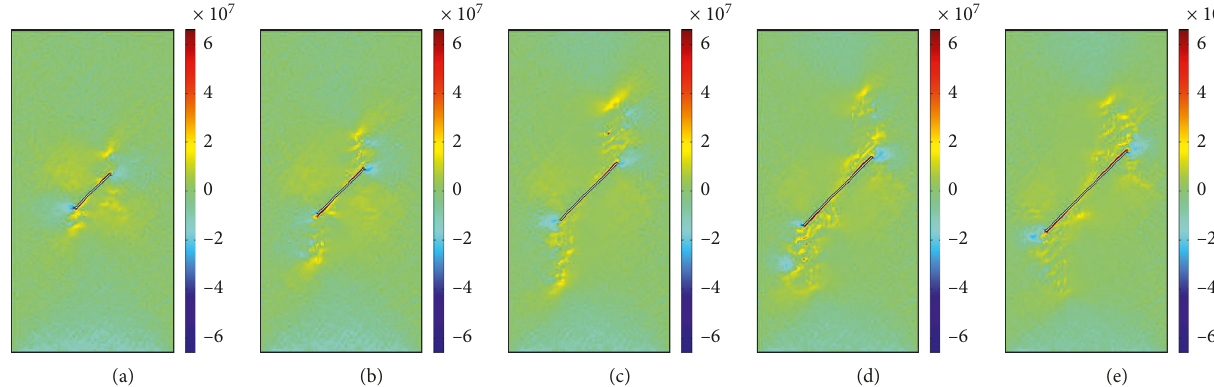
Figure 15: Stress distribution of samples at Step 20 with various lengths (2 a ) of preexisting fracture, (a) 2 a (c) 2 a 25 mm; (d) 2 a 30mm; (e) 2 a 35mm. (cid:30) (cid:30) (cid:30)